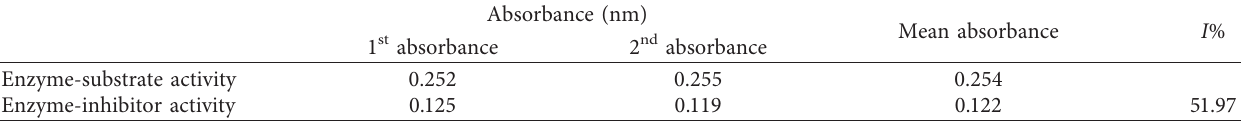
Table 1: Inhibitory activity of cinnamon bark oil on PPO activity of the Annona muricata extract.